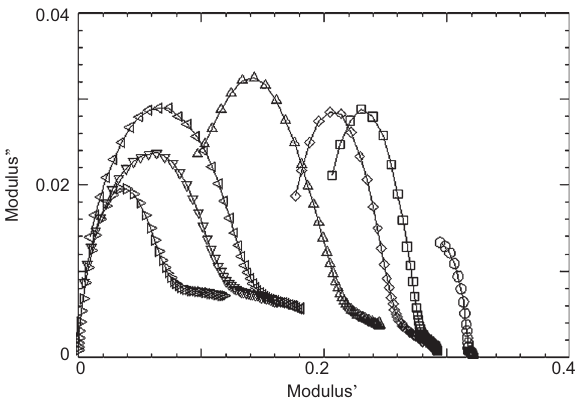
Figure 10 Argand’s plot for the electric modulus at 120 ° C: ○ PS; □ PS+5% GTR; ◊ PS+10% GTR;  PS+20% GTR;  PS+40% GTR;  PS+50% GTR;  PS+70% GTR.